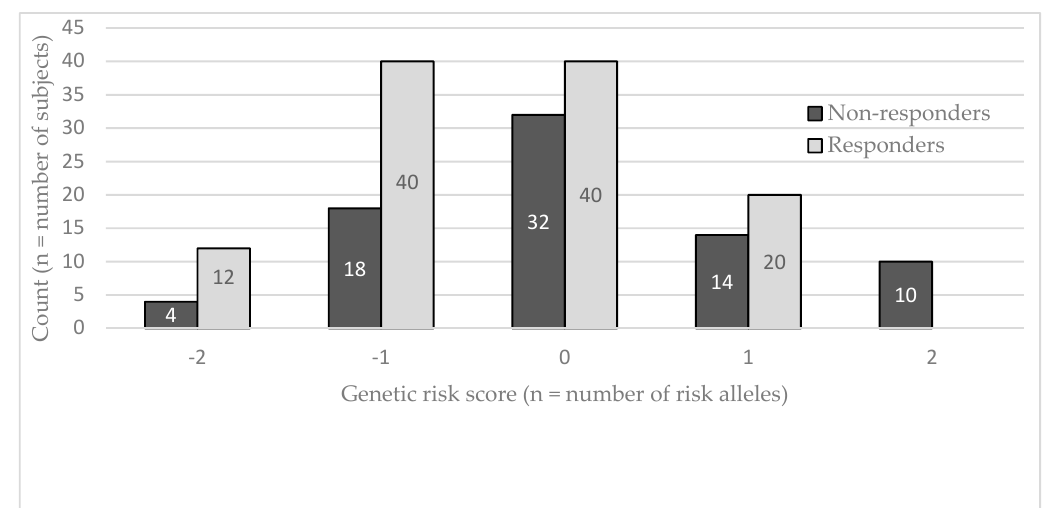
Figure 2. Risk score (GRS) distribution in Mexicans according to 5 SNPs ( n = 190 individuals). If a GRS is positive, the subject carries more at-risk alleles. If a GRS is negative, the subject carries more beneficial alleles.